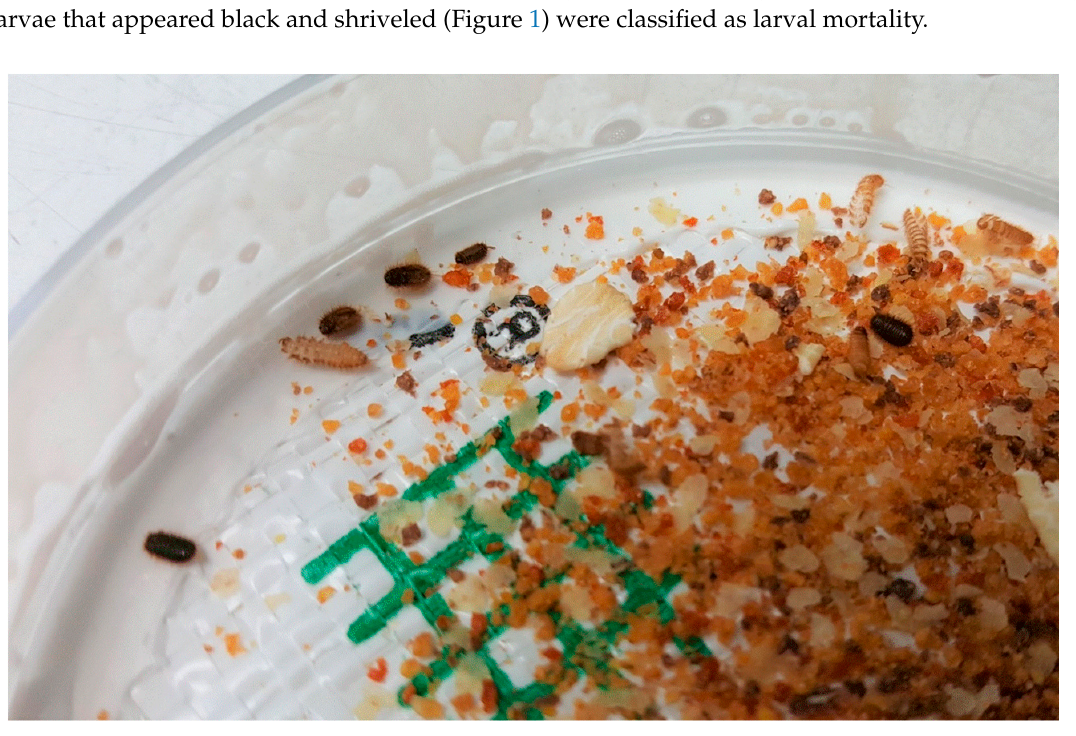
Figure 1. Dead Trogoderma granarium larvae exposed on deltamethrin-treated packaging material for ~4 weeks. Dead larvae appear dark brown/black in color and shriveled in appearance near the edge of the treatment arena.